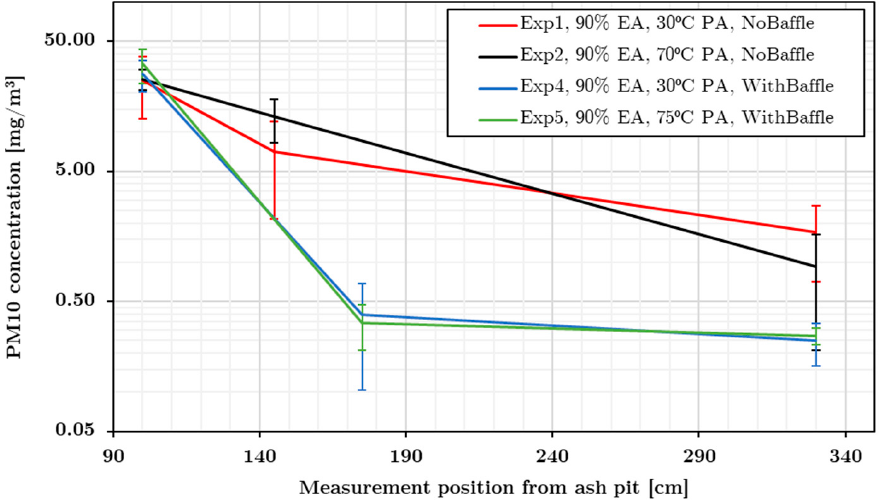
Figure 8. PM 10 measurement result for the system with and without baffle and for the system with and without primary air preheater (EA: excess air, PA: primary air).